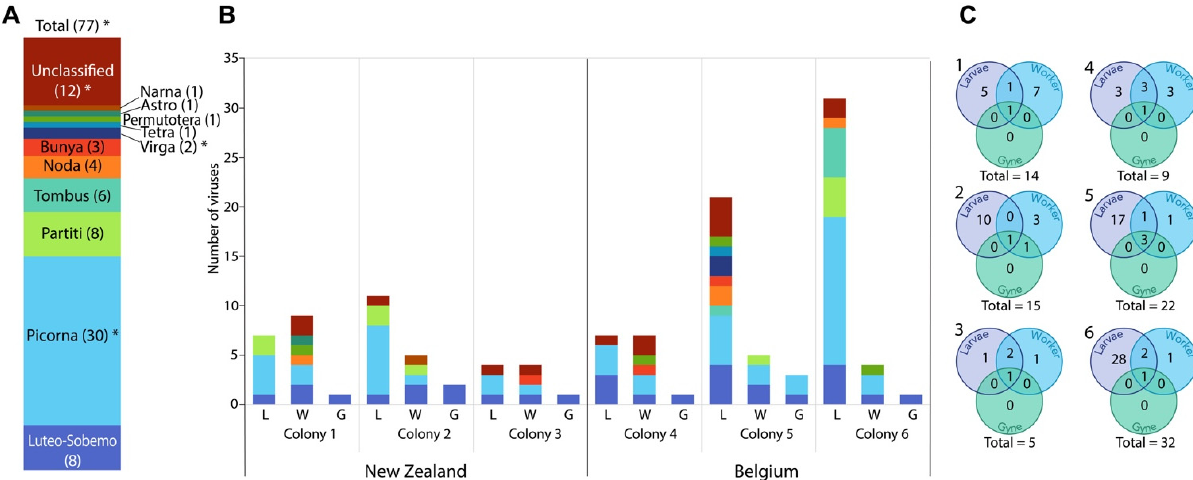
Figure 1. Number of viruses identified in Vespula vulgaris colonies from New Zealand and Belgium. ( A ) Total number of viruses identified (77) sorted by viral family. * indicates some previously identified viruses (Total (77) = 68 novel and nine previously identified viruses; of which six previously identified were Picorna, two unclassified, and one Virga). ( B ) Number of viruses identified in each sample from each colony (L = larva, W = worker, G = gyne) sorted by viral family (see also Table S3). ( C ) The overlap of viruses between wasp life-stages within wasp colonies (see also Table S4). Total viruses identified in each colony is indicated.